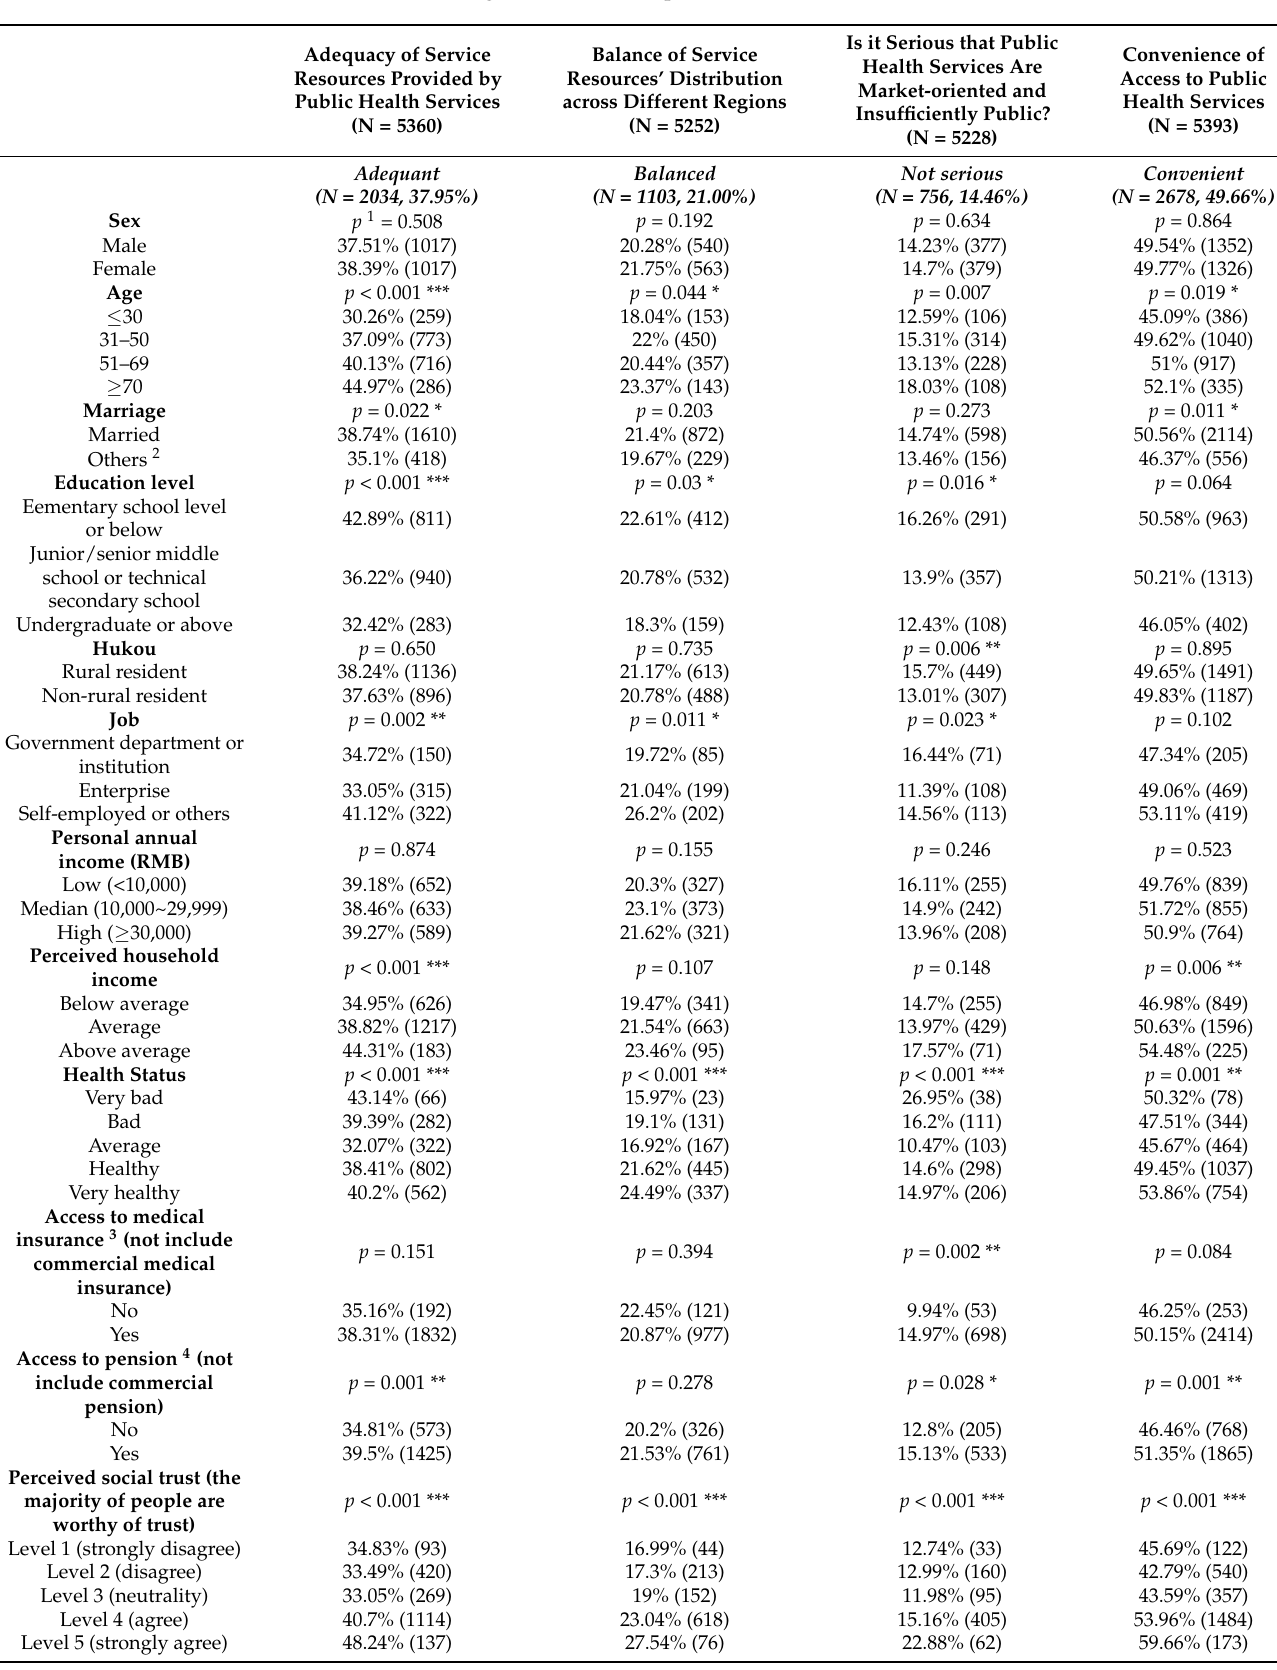
Table 1. Bivariate Associations Between Sociodemographic Characteristics and Service resource evaluation among CGSS (2013)